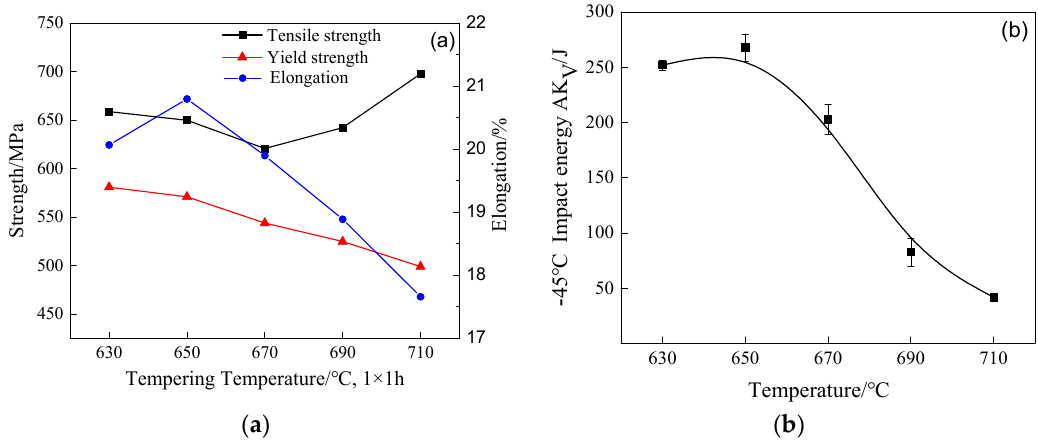
Figure 2. Strength, elongation ( a ), and impact energy ( b ) of tempered steel at different temperatures.